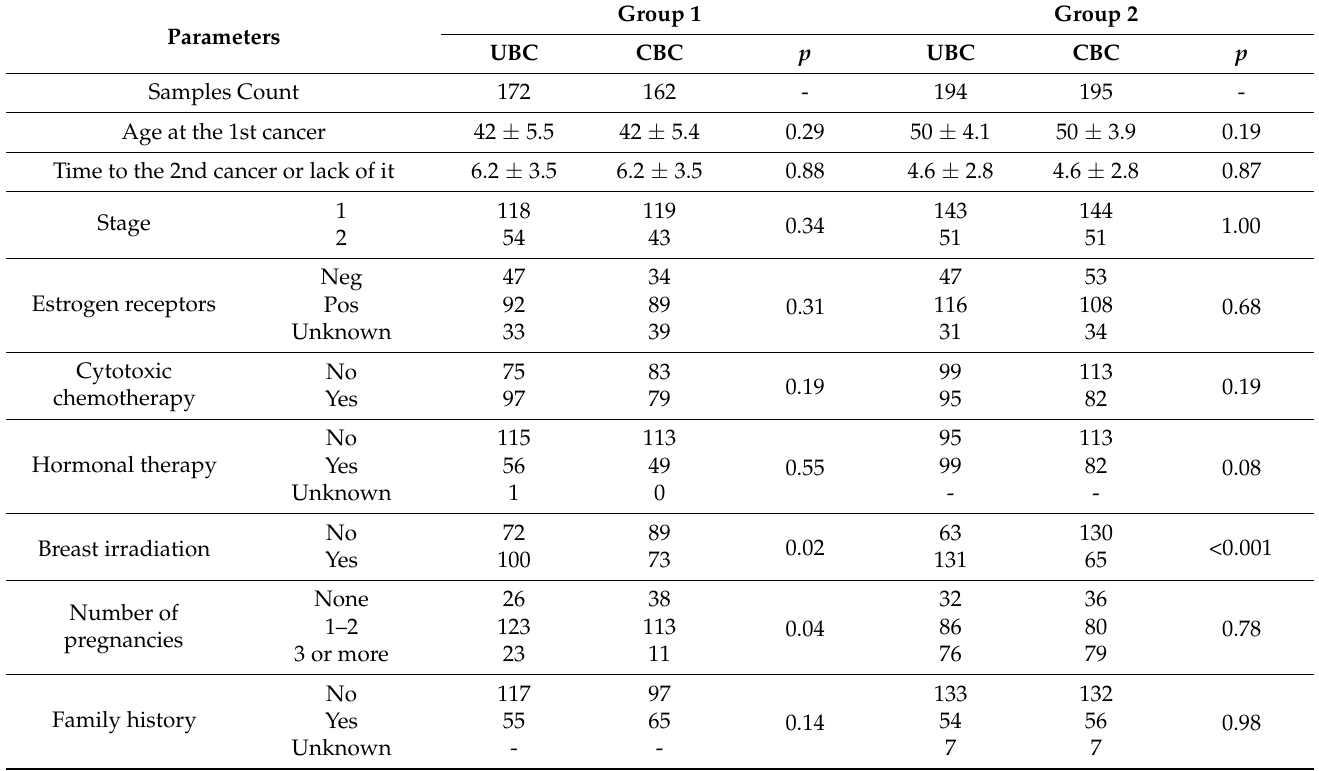
Table notes: p -values show significance of differences between contralateral and unilateral breast cancers (CBC and UBC respectively). For continuous data, table shows mean ± std deviation; the significance is estimated